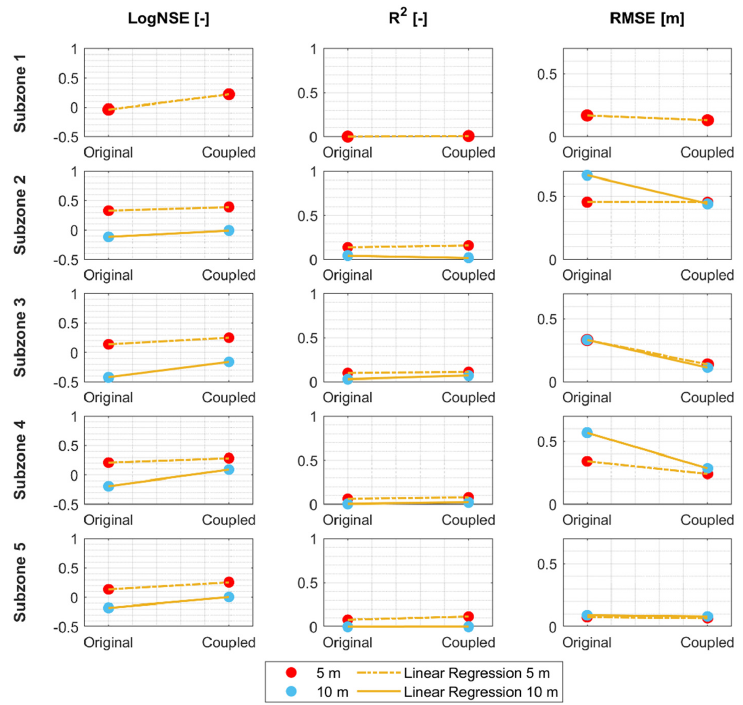
Figure 5. Calculated GOFs for each subzone in the 5 m and 10 m model.